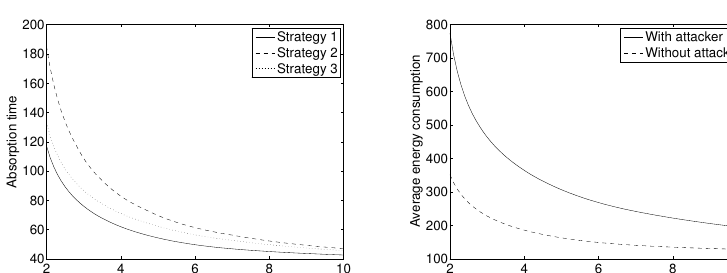
Figure 5: Relative approximation er- ror for R and τ , Strategy 3